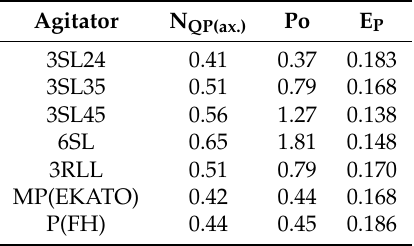
Table 1. The pumping efficiency of axial flow agitators in the turbulent flow region—cylindrical vessel with dished bottom and four radial baffles, H / D = 1, d / D = 0.36, H 2 / d = 0.5 [6].